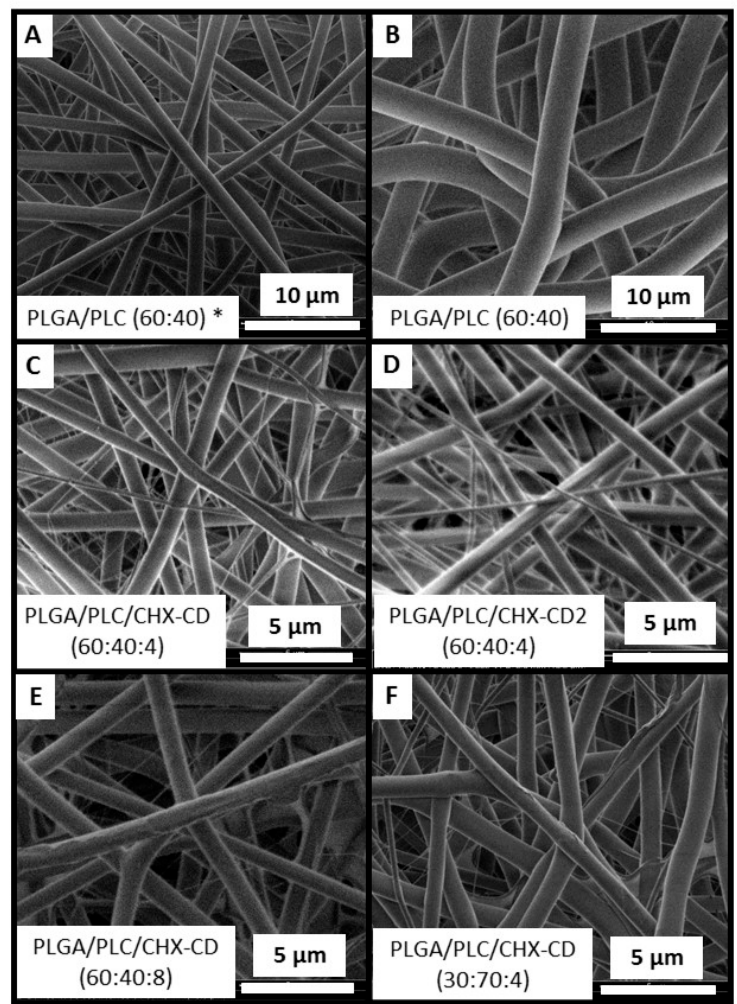
Figure 3. SEM images of fibers according to their formulations. Mean fiber diameter: ( A ) 1458 ± 174 nm; ( B ) 2996 ± 189 nm; ( C ) 655 ± 366 nm; ( D ) 642 ± 270 nm; ( E ) 824 ± 362 nm; ( F ) 746 ± 297 nm. In ( A ), fibers were electrospun with a 0.4 mm capillary. In ( D ), the lyophilized CHX-CD complex powder was added into the polymers solution.